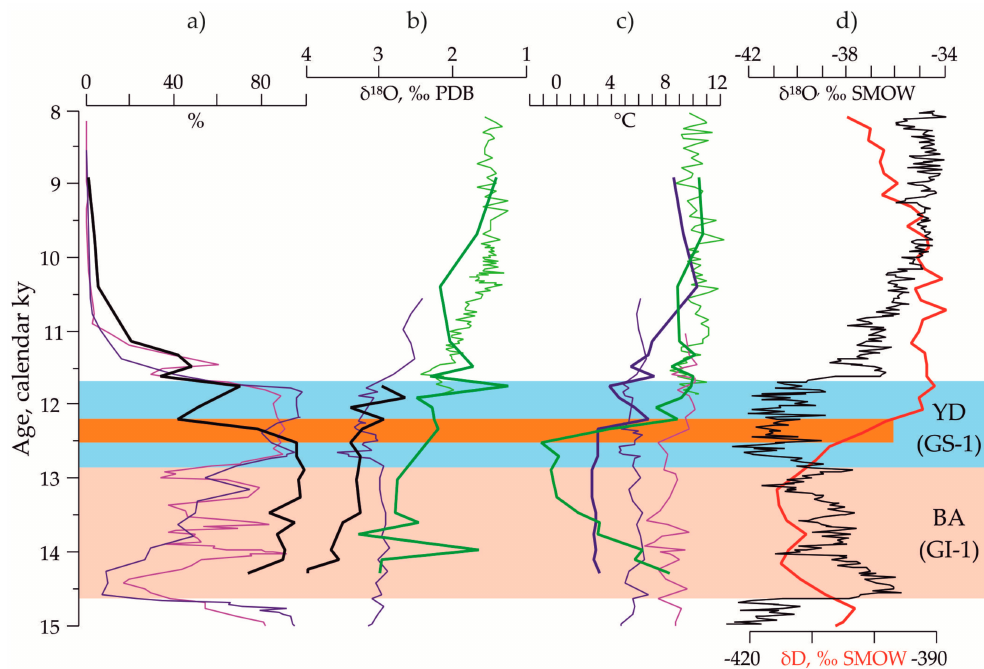
Figure 6. Summer paleotemperature for the water depth of 100 m in the core AMK-340 vs other paleoclimatic data: ( a ) down-core distribution of the polar planktic foraminifera N. pachyderma (sin.) in the cores AMK-340, black line [this study], RAPiD-10-1P, blue line, RAPiD-12-1K, green line, and RAPiD-15-1P, purple line [13,14]; ( b ) oxygen isotopic curves for the cores AMK-340, dark-green line based on G. bulloides shells and black line based on N. pachyderma (sin.) shells [this study], RAPiD10-1P, blue line based on N. pachyderma (sin.) shells, RAPiD-12-1K, light-green line based on G. bulloides shells, and RAPiD15-1P, purple line based on G. bulloides shells [13,14]; ( c ) paleotemperature for the cores AMK-340, dark-blue line based on the planktic foraminiferas and dark-green line based on the radiolarians [this study], RAPiD10-1P, blue line based on Mg/Ca in N. pachyderma (sin.) shells, RAPiD-12-1K, light-green line based on Mg/Ca in G. bulloides shells, and RAPiD15-1P, purple line based on Mg/Ca in G. bulloides shells [13,14]; ( d ) oxygen isotopic curve for the Greenland NGRIP (North Greenland Ice Core Project) ice core, black line [46], and deuterium curve for the Antarctic EPICA (European Project for Ice Coring in Antarctica) ice core [47]. Light-blue bar is an interval of the cold YD (Greenland Stadial GS-1), rose bar is an interval of the warm BA (Greenland Interstadial GI-1), and light-brown bar is a transition to the warmer conditions [this study] within the conventional cold